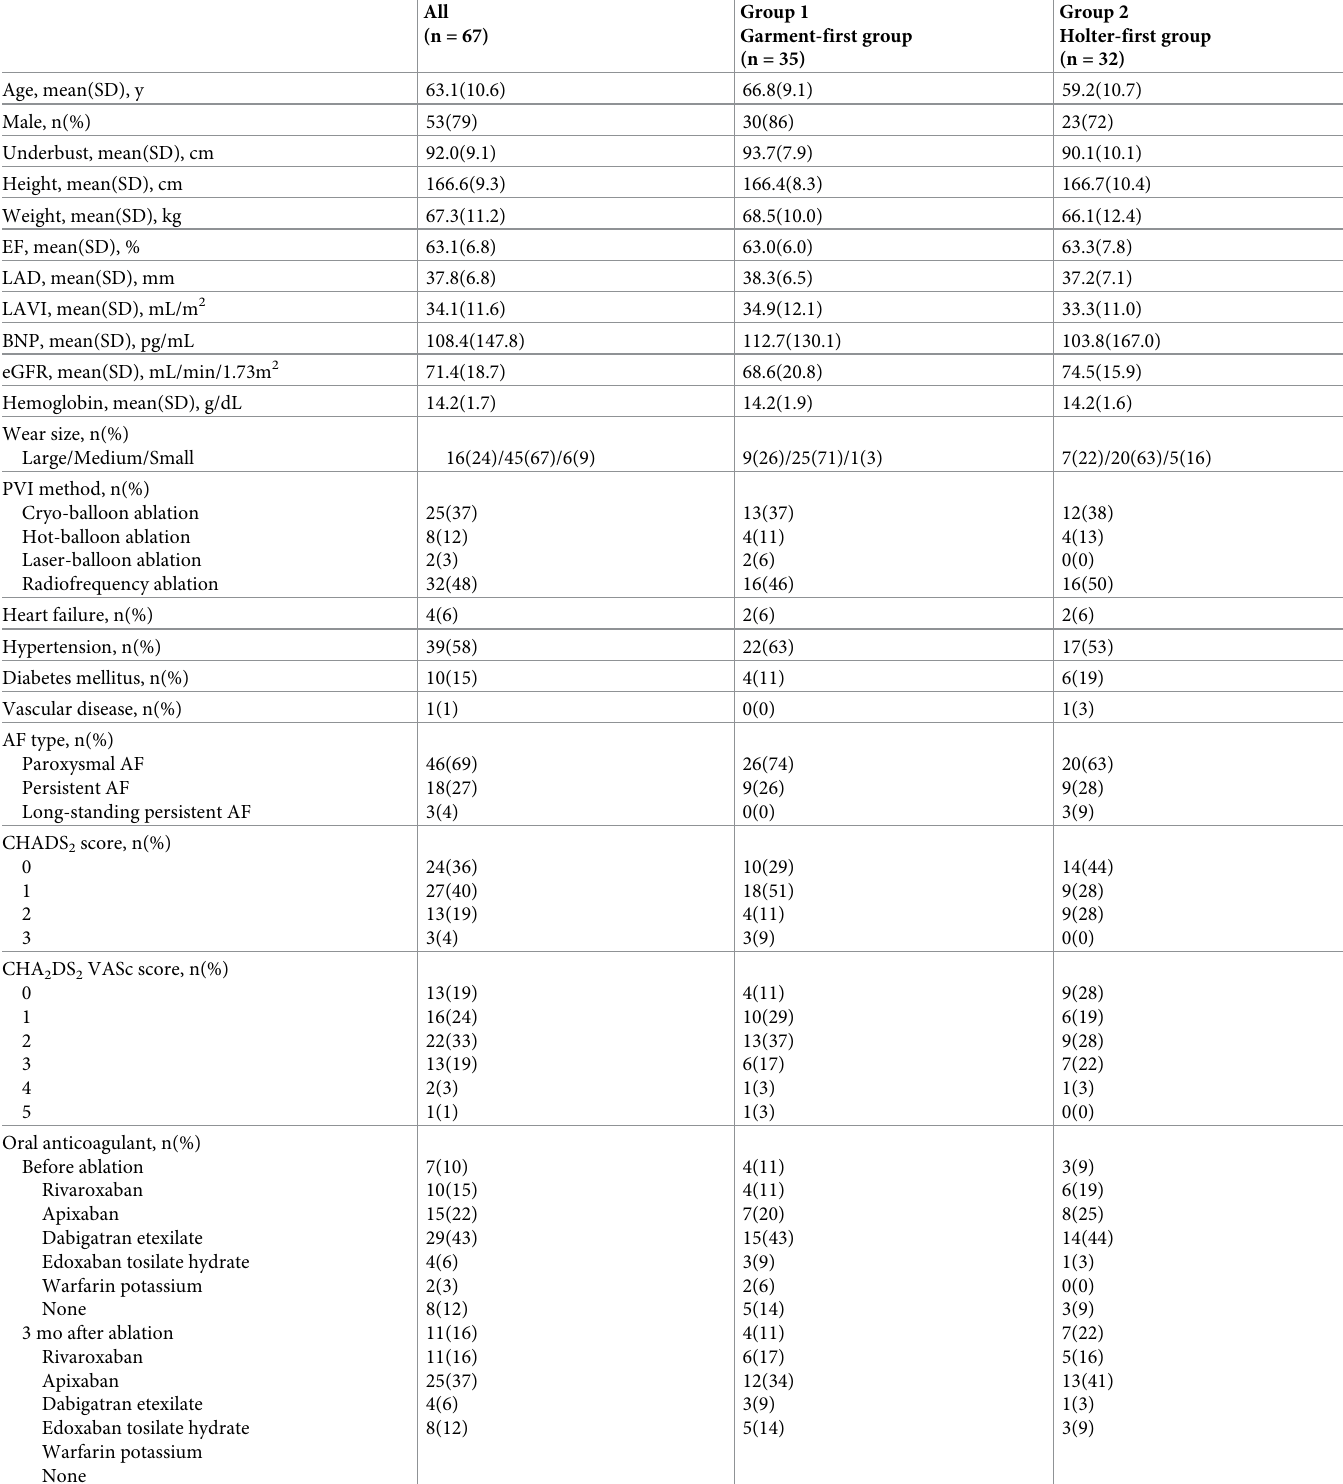
Table 1. Patient